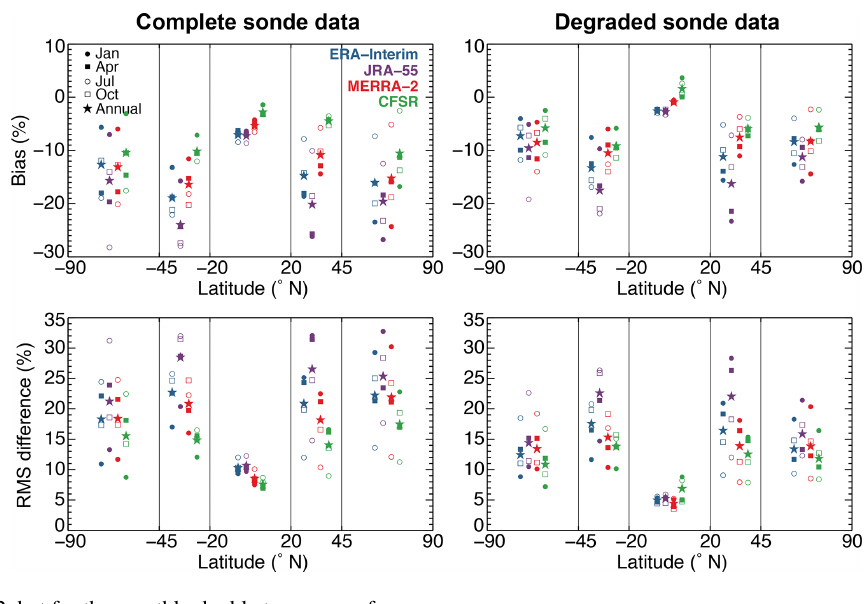
Figure 3. As in Fig. 2, but for the monthly double tropopause frequency.